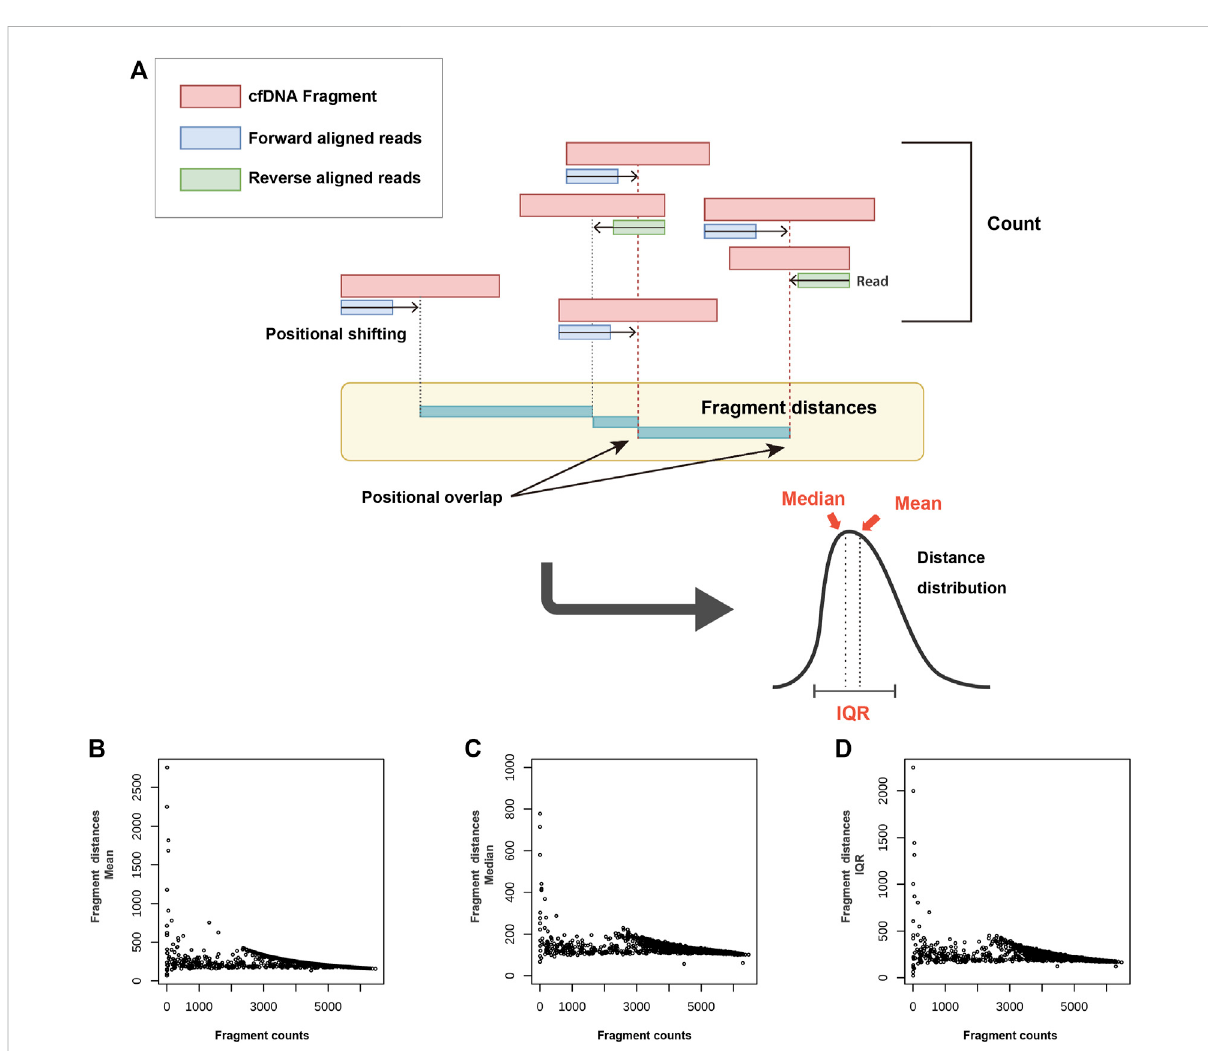
FIGURE 2 Concept and characteristics of fragment distance (FD) (A) and its relationship with fragment count (FC) (B – D) . After positional shifting in the direction of aligned reads, the distance between the closest positions is calculated. While the count is obtained as a single value based on a speci fi c region, theFDallows theuse of various representative values (mean, median, and IQR) throughthe distribution data. With respect to therelationship between the FC and FD representative values [mean (B) , median (C) , and IQR (D) ], the FD is shown to decrease as the FC increases. This trend, however, is not observed across all regions. cfDNA: cell-free DNA; IQR: interquartile